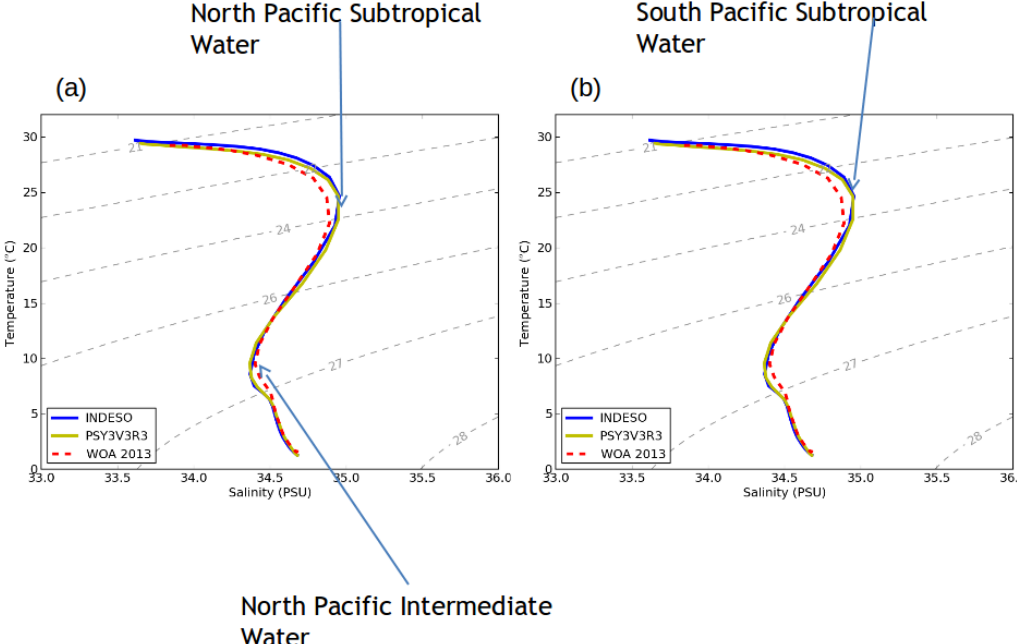
Figure 16. T – S diagrams from INDO12 simulation (green line) averaged on the North Pacific area (a) and the South Pacific area (b) and compared to climatologies WOA 2009 (dotted line) and PSY3V3R3 (yellow) in 2012. Salinity (PSU) and temperature ( ◦ C) are plotted along x and y axes,